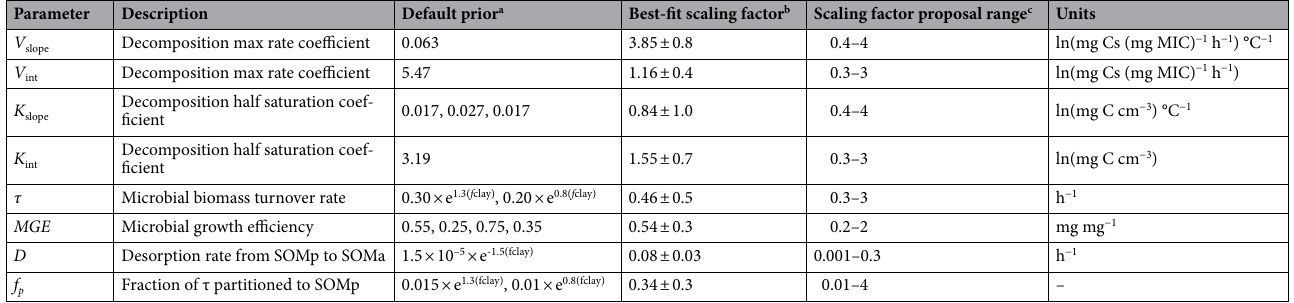
Table 1. MIMICS parameters included in the Monte Carlo (MC) optimization and the subsequent best-fit values found for the Reynolds Creek Experimental Watershed and Critical Zone Observatory (RCEW-CZO) calibration data. a Further information regarding MIMICS parameters and default initial values provided in 26 b Parameter proposals in the MC algorithm were conveyed as a factor of the initial prior value(s). Presented standard deviation is derived from the parameter ensemble (n = 30) with RMSE 1.8–2.0 c Factor proposals for each parameter were confined to agree with natural analogs and to reduce computational demands. See Methods for further